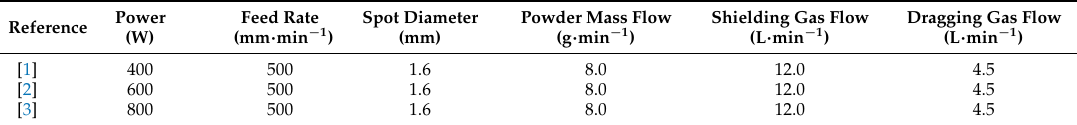
Table 4. Laser Metal Deposition (LMD) experiments process parameters.